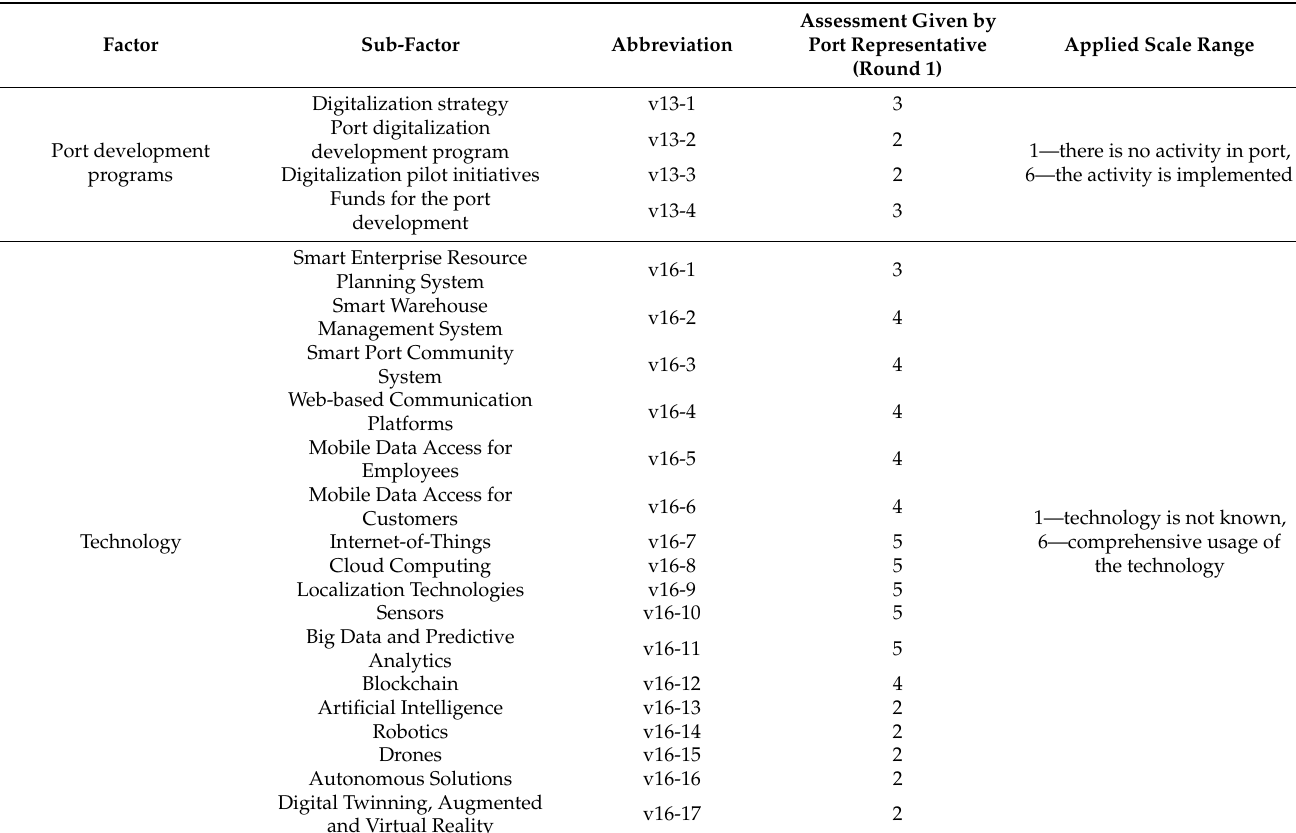
Table 3. Part of questionnaire filled by Elblag port representative (first round of interviews).